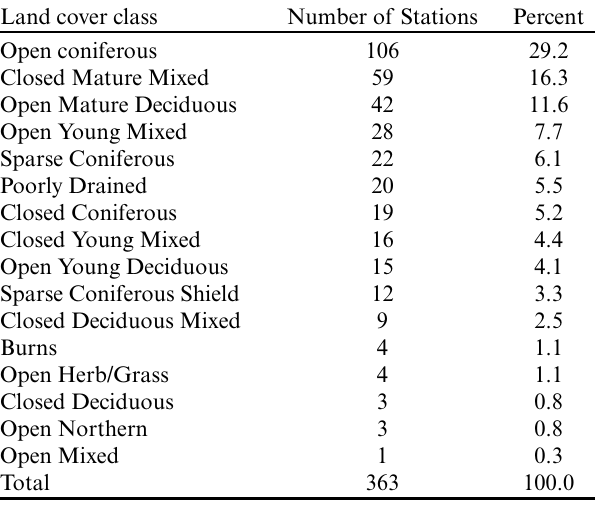
Table 1 . Distribution of point count samples amongst land cover classes derived from the 250 m resolution Land Cover Map of Canada 2005 (LCC05; Latifovic et al.